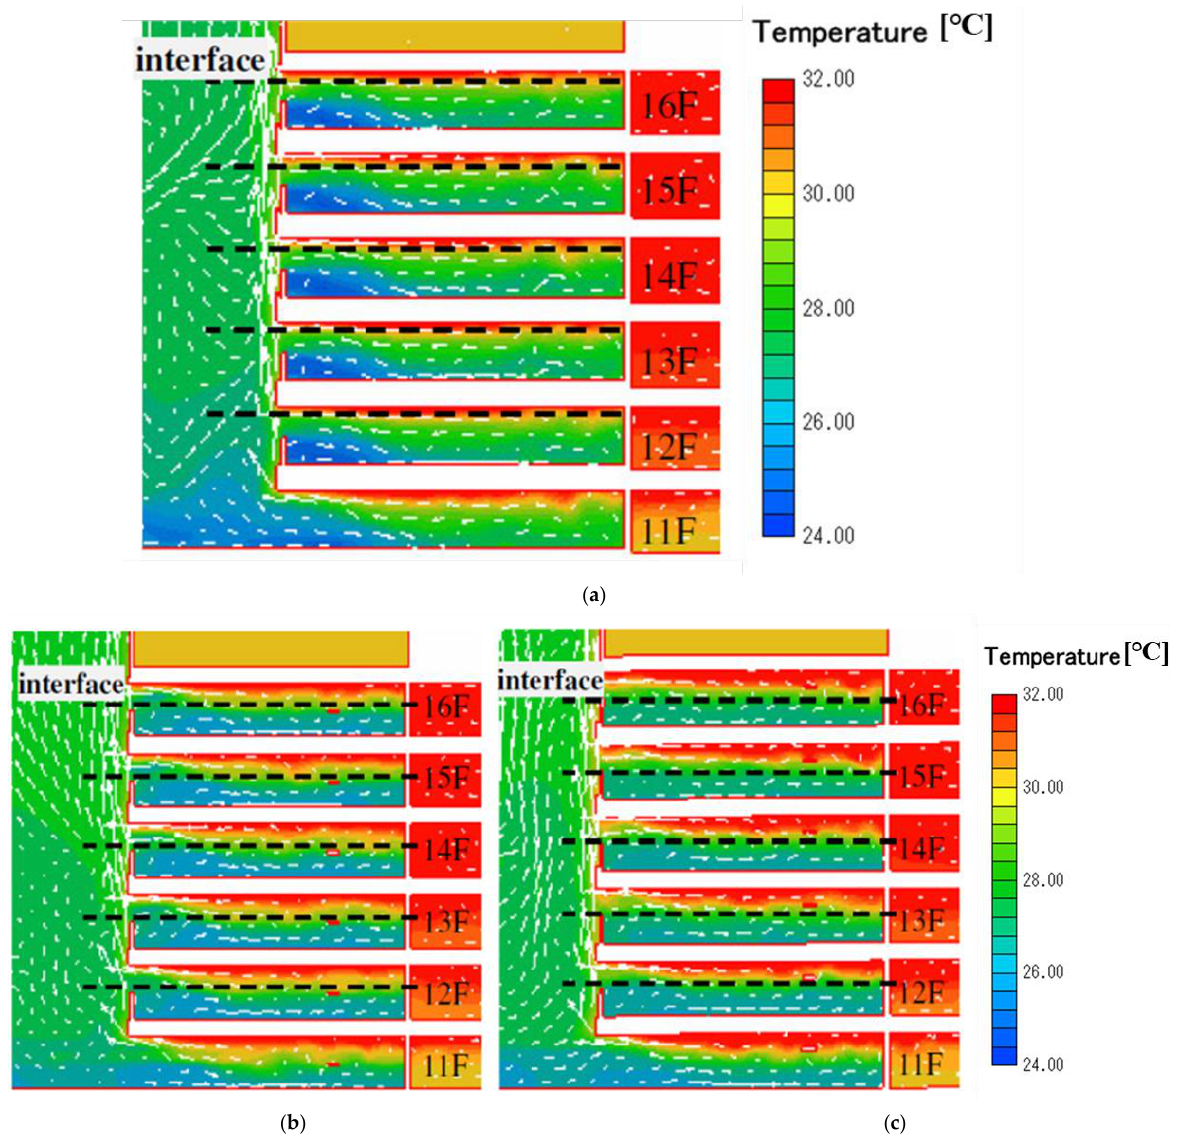
Figure 22. Temperature distribution with various heat source heights. ( a ) Heat source at ground level when SA height was 0.4 m. ( b ) Heat source at 1m when SA height was 0.4 m. ( c ) Heat source at 1.5 m when SA height was 0.4 m. Table 13. PMV values with 2.45 m ceiling